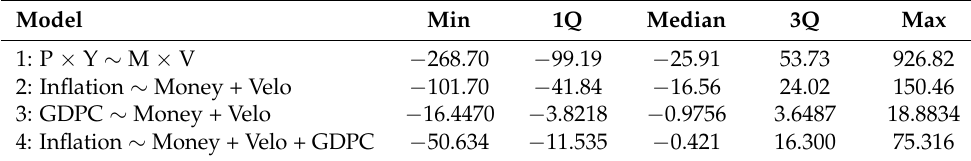
Table 10. Residual valuation,